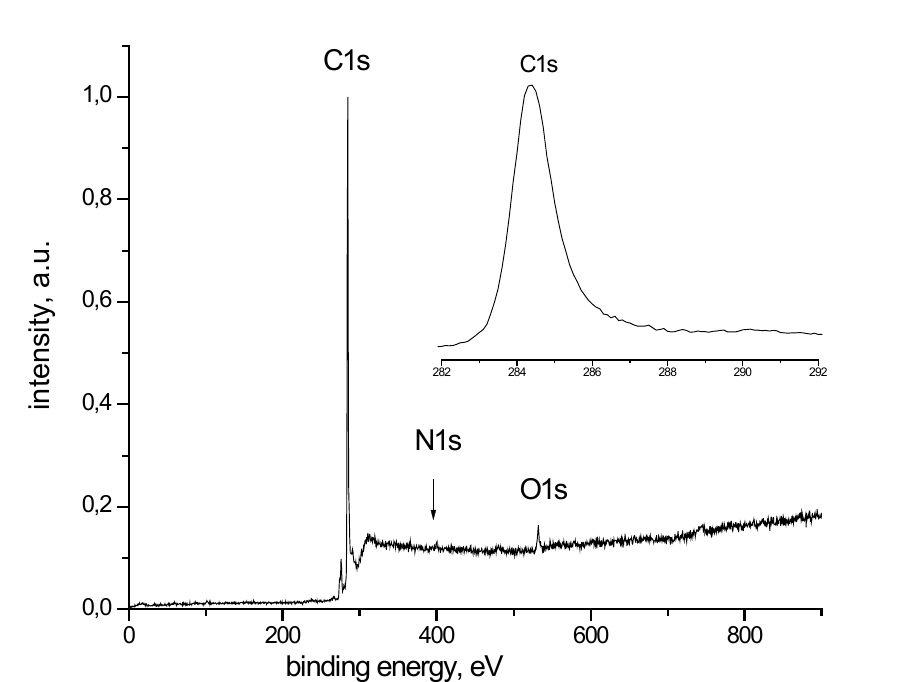
Figure 2. Overview XPS spectrum of functionalized SWCNTs (synthesis 7 in Table 1). The inset shows the spectrum of C1s core